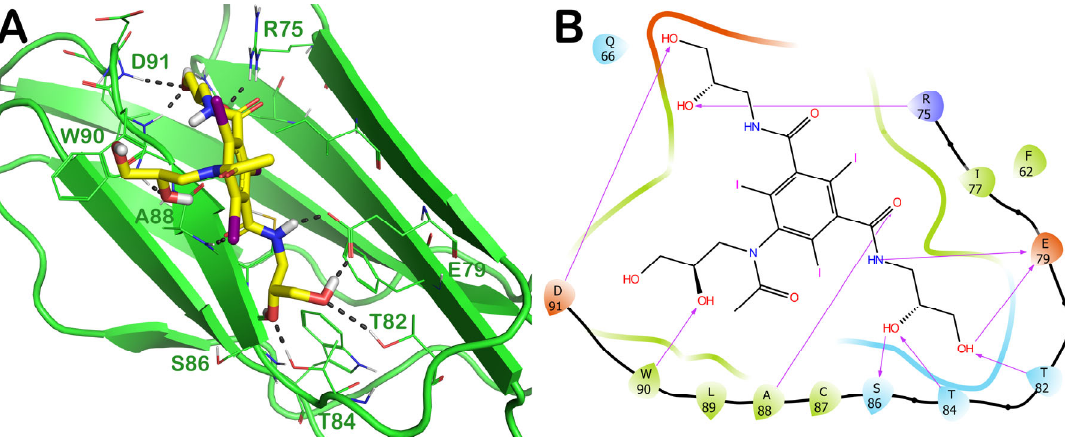
Figure 3. ( A ) Docking output of compound ZINC000003830946 (yellow sticks) within the surface of the irisin monomer (PDB ID 4LSD, green cartoon) involved in the dimerization process. The key interacting residues are represented by lines. The H bonds are depicted as do tt ed lines. Non-polar hydrogen atoms were removed for the sake of clarity. ( B ) A 2D representation of the contacts estab- lished by ZINC000003830946 within the irisin monomer interface. Images were prepared using PyMOL and the Ligand-Interaction Diagram application implemented in Maestro.